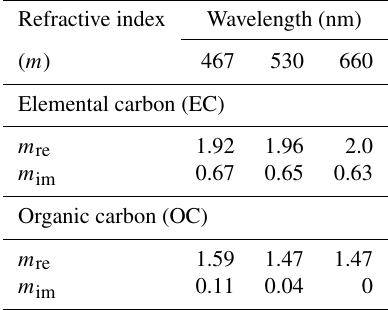
Table B1. Values of m re and m im used in this study (Kim et al., 2015) for elemental carbon (EC) and organic carbon